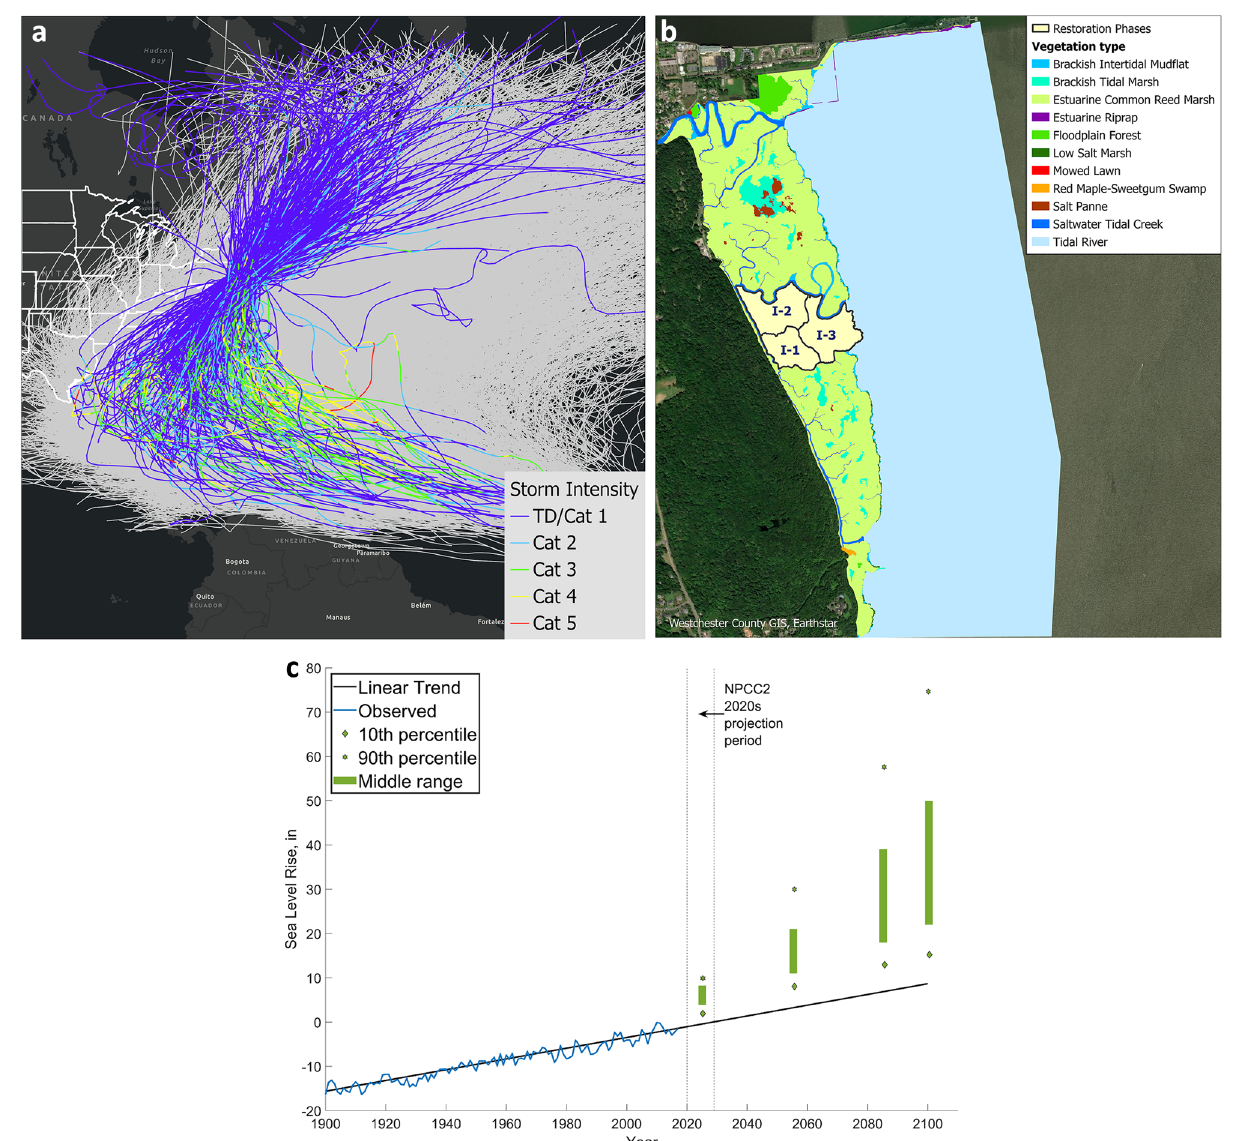
Figure 2. ( a ) Storm ensemble for NJ/NY/CT coasts predicted by the NASHM 11 (upper left). (ArcGIS basemap credit: ESRI, HERE, Garmin, SafeGraph, FAO, METI/NASA, USPS, EPA, NPS). ( b ) Piermont Marsh with a 3-phase restoration plan to restore Typha in the 40-acre area (upper right). (ArcGIS basemap credit: Westchester County GIS, Maxar). ( c ) SLR at Battery 12 (lower